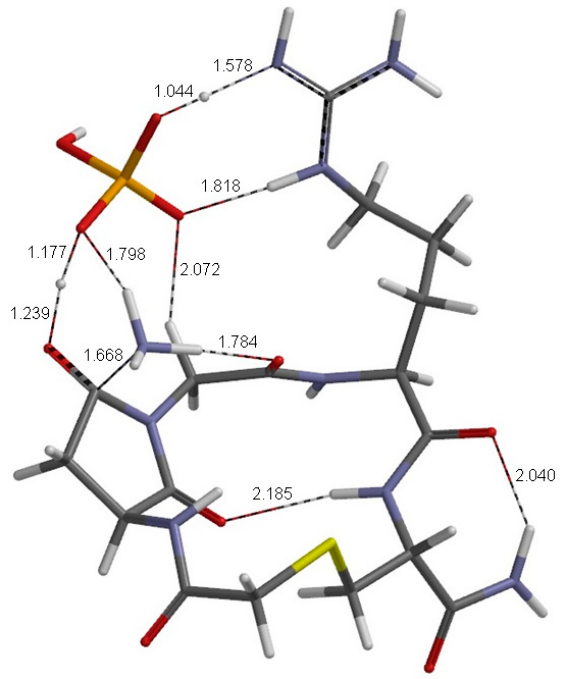
Figure 8. The geometry of TS2, the transition state of the second step (deammoniation) connecting TH2 (Figure 7) and PC (Figure 9). Selected interatomic distances are shown in Å. Grey: carbon; white: hydrogen; blue: nitrogen; red: oxygen; orange: phosphorus; yellow: sulfur.